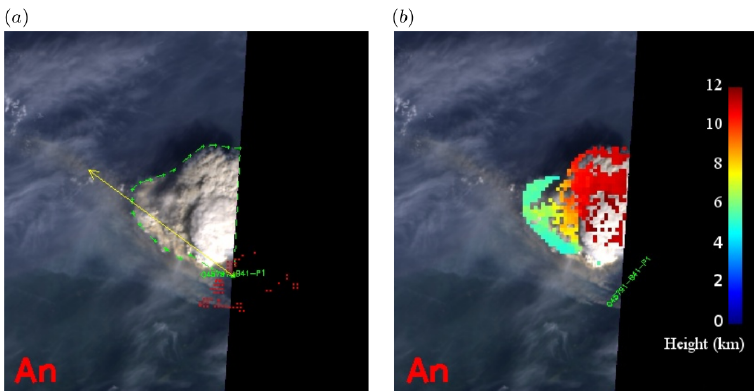
Figure 11. Overview of the highest fire plumes present in the current North American subset of the MISR plume height data set of Nelson et al. (2013), derived using the MINX tool shown in Fig. 4. The reference of this fire in the MISR data set is O45791-B41-P1, and it was observed in the Northwest Territories (Canada) on 27 July 2008. It shows the nadir image recorded by MISR, together with the plume contour set by the operator of the MINX software (a) , the estimated wind direction (yellow arrow in a ), and the stereo-height retrieval (b) . Part of the image is black as the fire was located on the edge of the MISR swath. Images are taken from the MISR plume height project website (see footnote 1).